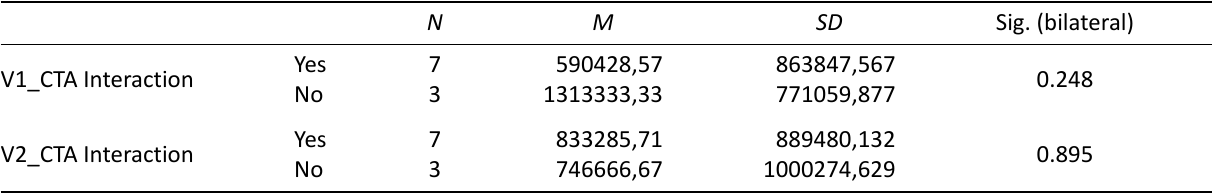
Table 5. T‐Student test: CTA and video interaction. N M SD Sig.